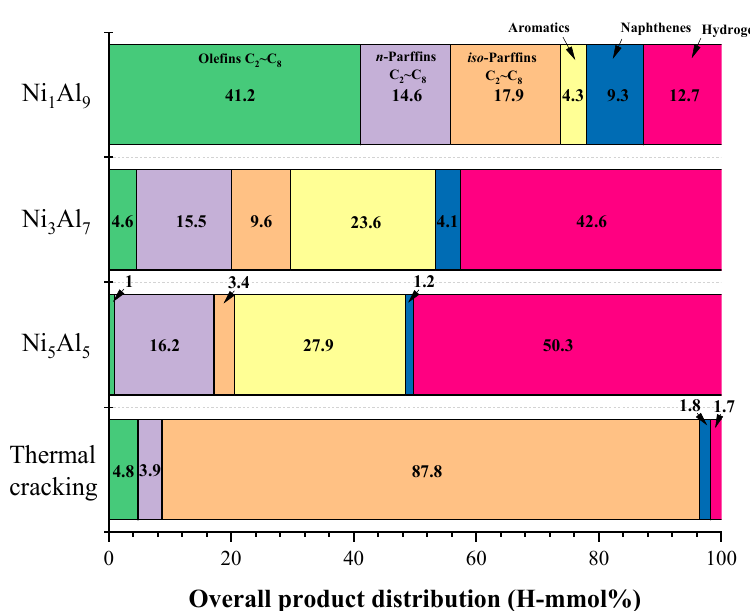
Figure 8. Overall product distributions at 450 °C and 4 MPa.